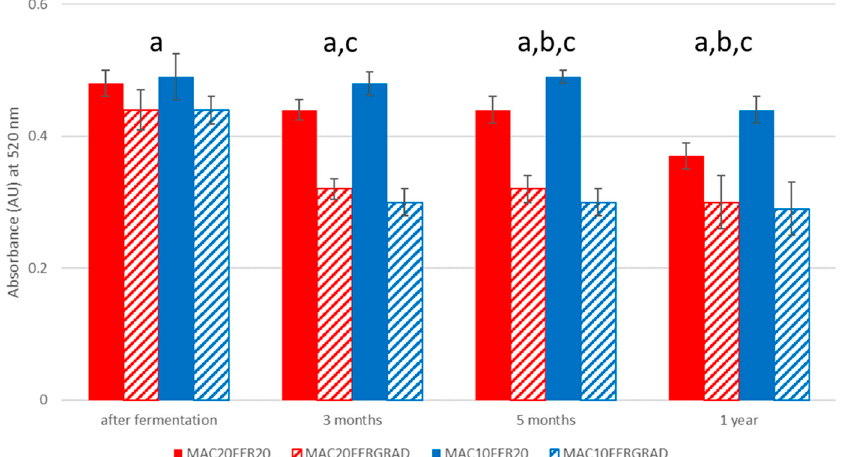
Figure 3. Evolution of the red color intensity of one-year-ageing wines produced through four different processes. a: significant differences due to differences in the fermentation temperature, b: significant differences due to differences in the maceration temperature, c: significant interaction between the maceration temperature and the fermentation temperature ( p < 0.05).